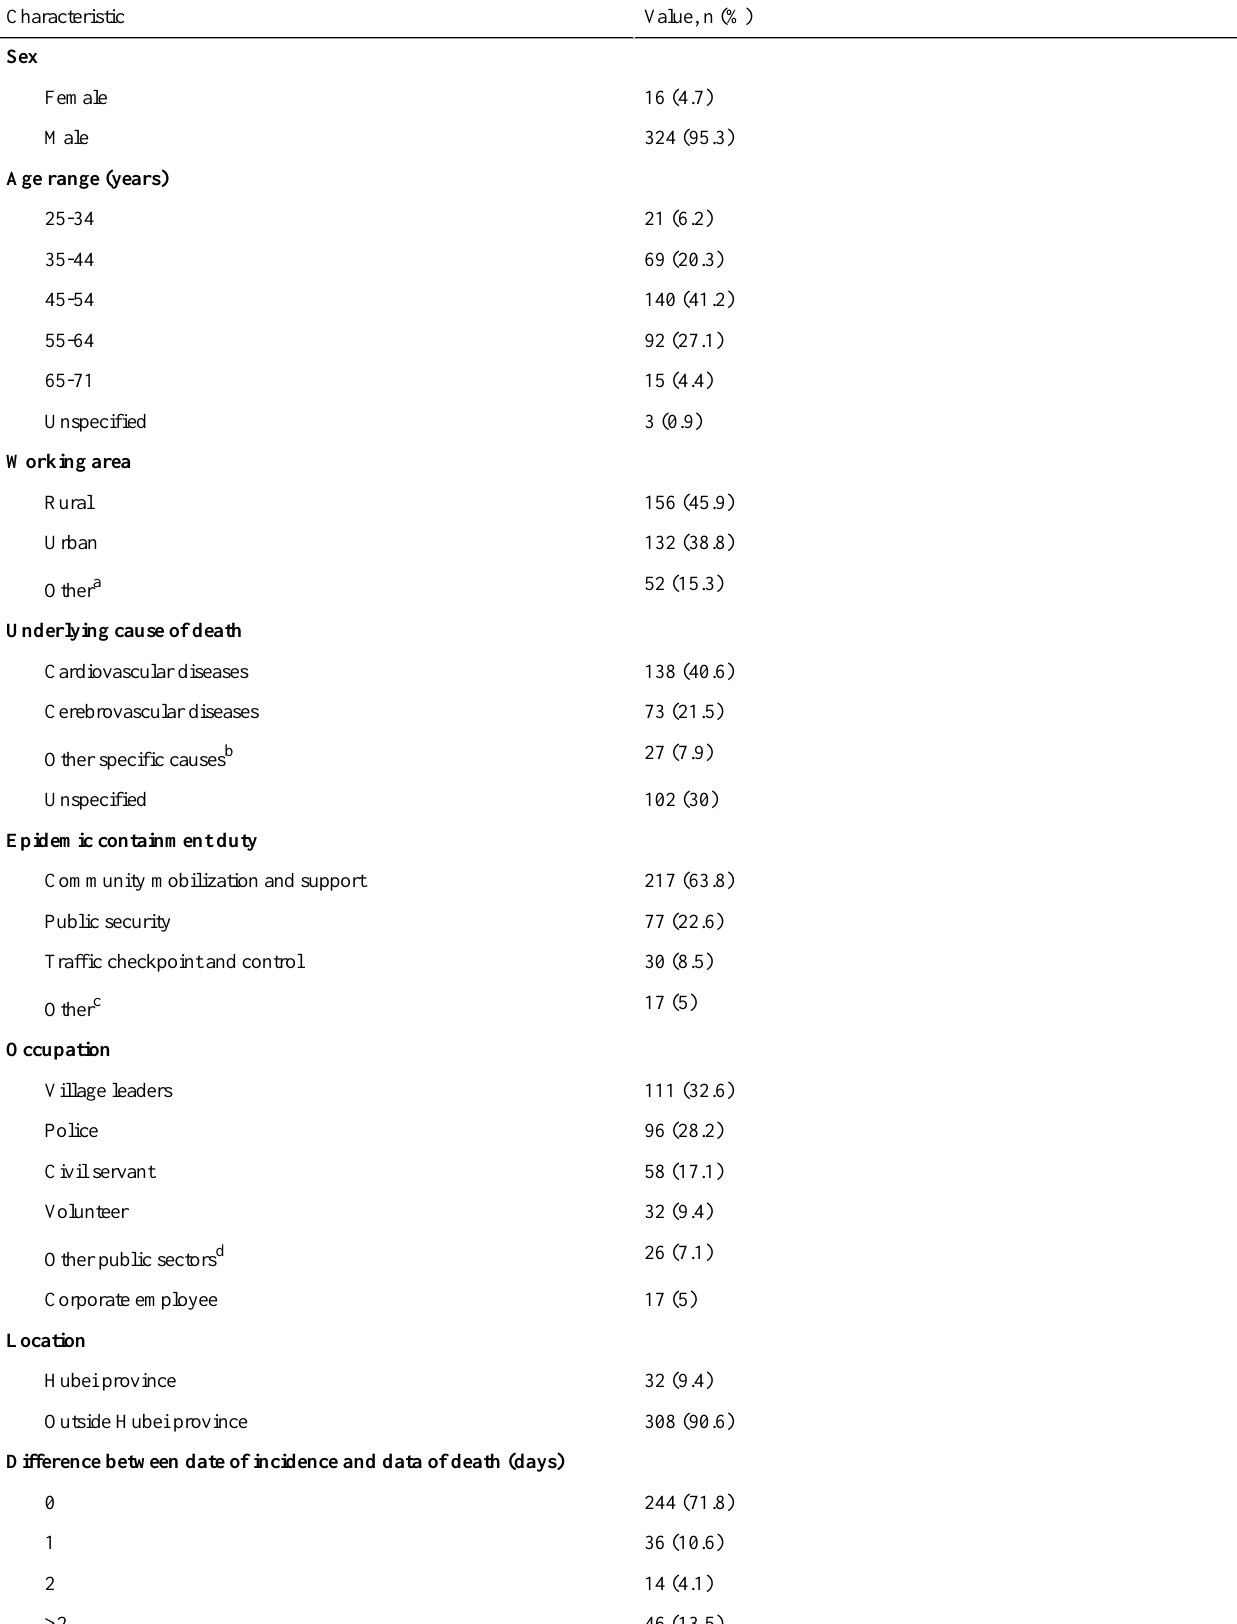
Table 1. Characteristics of documented frontline workers who died due to overwork during the emergency response to COVID-19 in China between January 20 and April 26, 2020